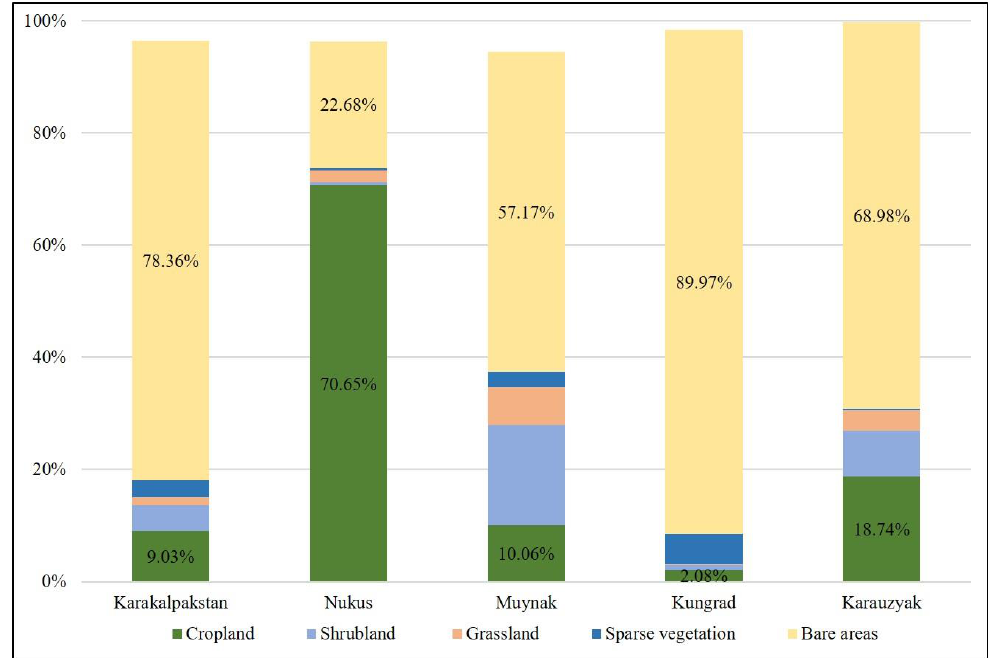
Figure 3. Major land cover types in the Amu Darya Delta.